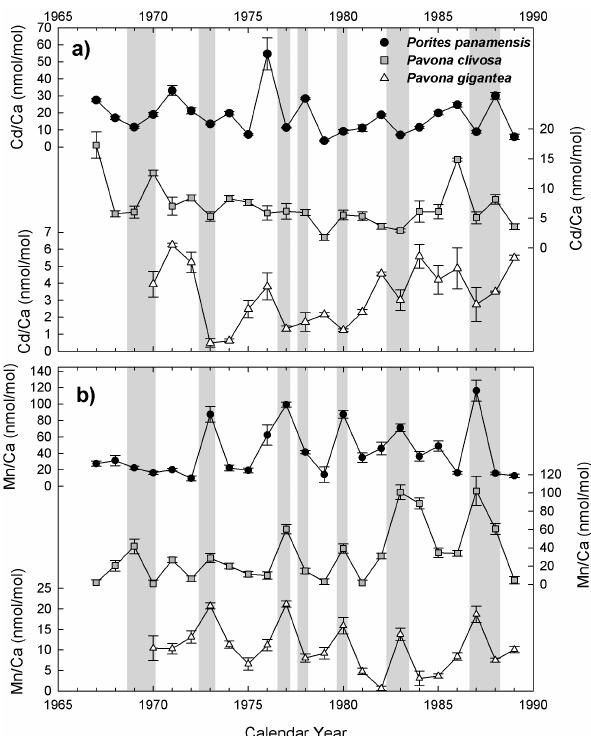
Fig. 3. Temporal variation (1967 to 1989) of the annual Cd/Ca ra- tios of the three coral species used in this study (a) , and tempo- ral variation of the Mn/Ca ratio in the skeleton of the same coral species (b) . The error bars ( ± 1s.d.) were obtained from the repli- cates ( n =3) used to calculate the annual average. The gray bars define the timing and duration (months) of the El Ni˜no events and the arrows indicate the cold events of La Ni˜na defined by Trentberth